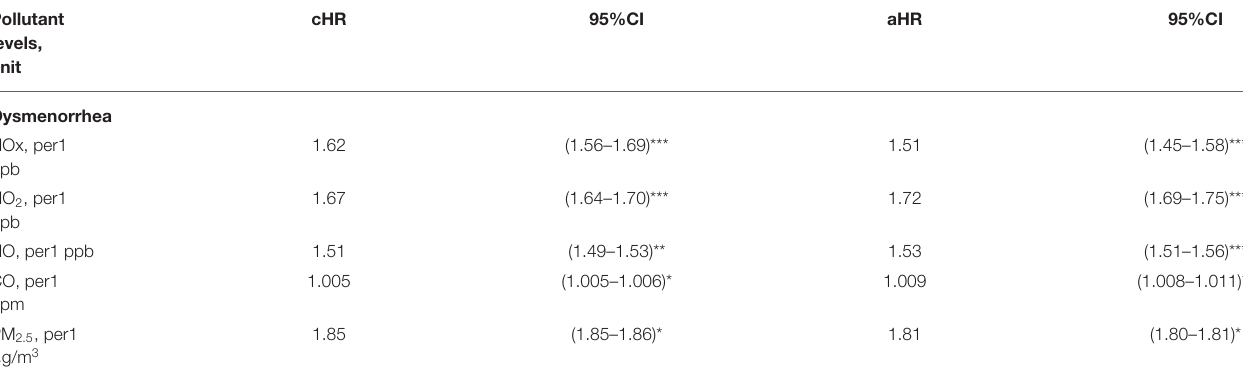
TABLE 4 | Associated HRs in participants exposed to every increment of one unit of yearly average concentrations of air pollutants. Pollutant